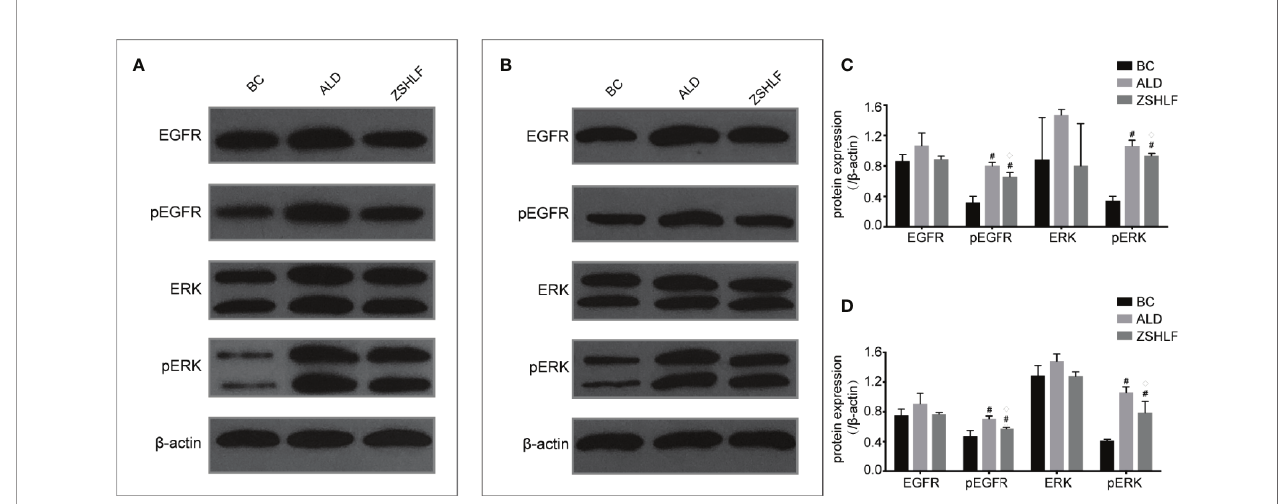
FIGURE 7 | Effects of Zi Shen Huo Luo Formula (ZSHLF) on the expression of EGFR, ERK, pEGFR, and pERK in H9c2 cells and rat cardiac fi broblasts (RCFs) in different groups as assessed by western blot analysis. (A) The protein expression of EGFR, pEGFR, ERK, and pERK in H9c2 cells was measured by western blot analysis. (B) The protein expression of EGFR, pEGFR, ERK, and pERK in RCFs was measured by western blot analysis. (C) Relative optical density (ROD) of EGFR, pEGFR, ERK, and pERK in H9c2 cells. (D) ROD of EGFR, pEGFR, ERK, and pERK in RCFs. The data represent the mean ± standard deviation, n =3. # P < 0.05 vs. the BC group; ◇ P < 0.05 vs. the ALD